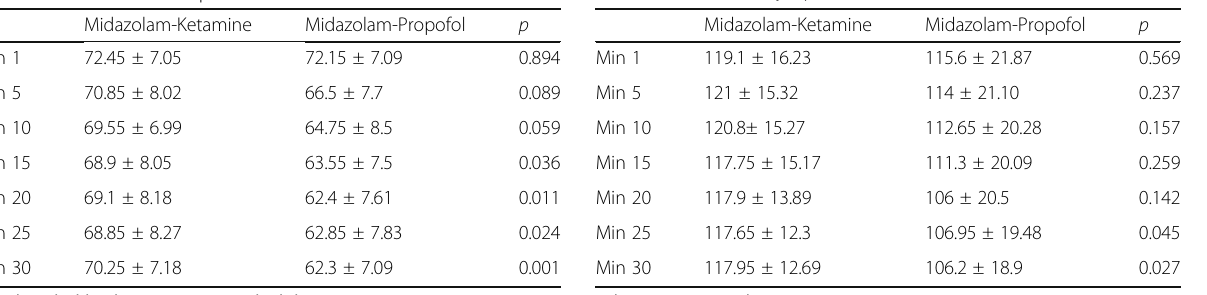
Table 5 Diastolic blood pressure values